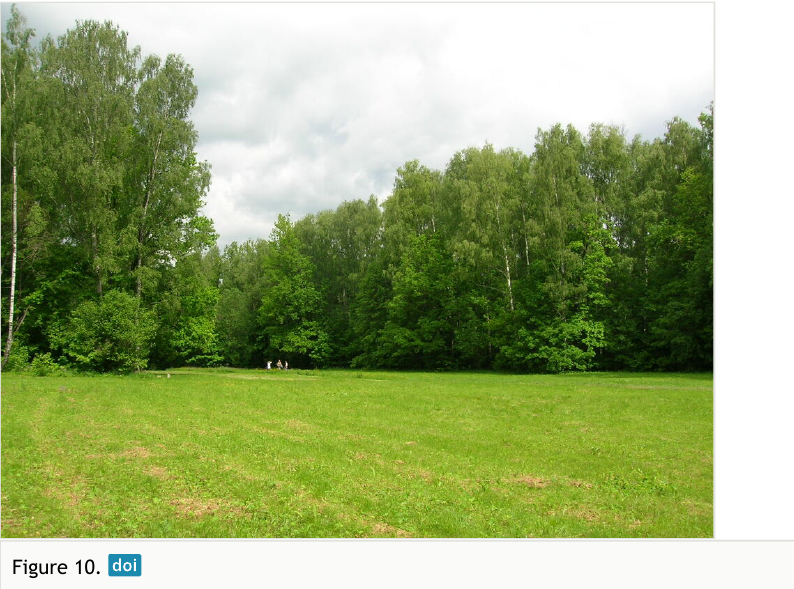
Typical plant communities of the Yasnaya Polyana local flora (Tula Oblast, Russia): managed meadow (Molinio-Arrhenatheretea) on the edge of broadleaved forest (Querco-Fagetea). Photo by the author (2006).